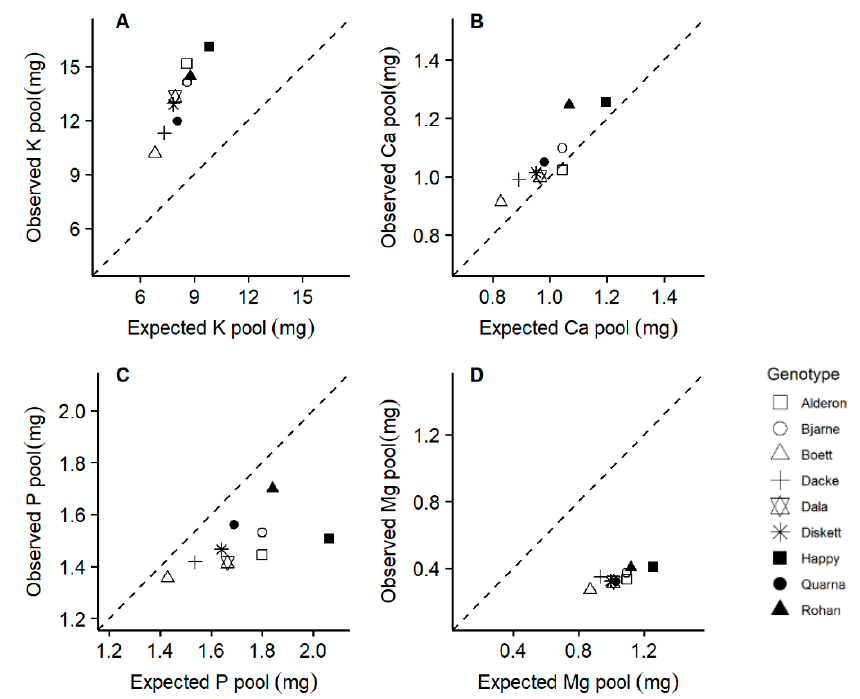
Figure 7. Comparison of the observed nutrient pools at day 20 and the expected pools for achieving optimum nutrient ratios. Expected nutrient pools were calculated based on the suggested optimum N:P:K:Ca:Mg ratios of 100:14.3:68.3:8.3:8.7 by Knecht and Göransson [41]. The broken lines indicate where the observed nutrient pools equal the expected values.